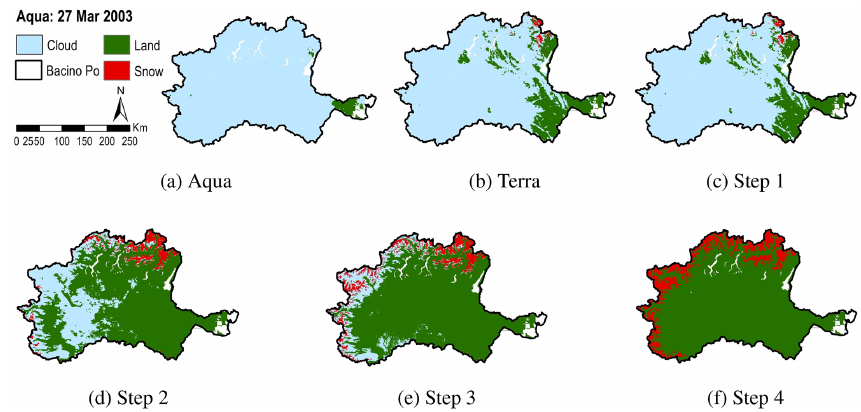
Figure 10. Cloud removal procedure applied to 27 March 2003. Aqua and Terra maps have a cloud coverage of 98 and 83%, respectively. Step 2 leaves out a cloud coverage of 29%. The intervention of step 3 affects 14% of the domain and step 4 closes the gap-filling